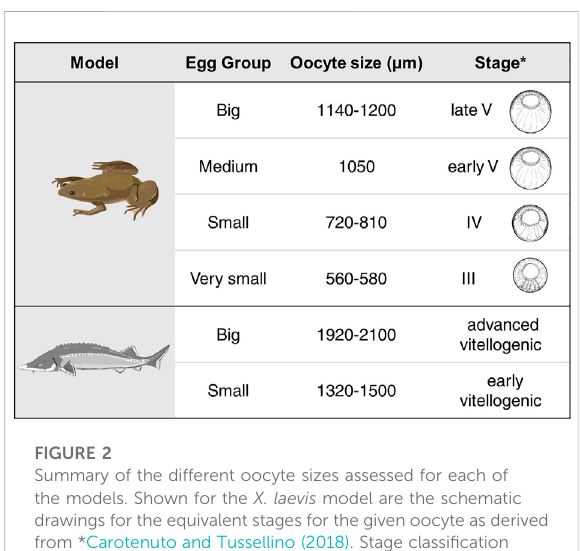
FIGURE 2 Summary of the different oocyte sizes assessed for each of the models. Shown for the X. laevis model are the schematic drawings for the equivalent stages for the given oocyte as derived from *Carotenuto and Tussellino (2018). Stage classi fi cation of the X. laevis oocytes are from Dumont